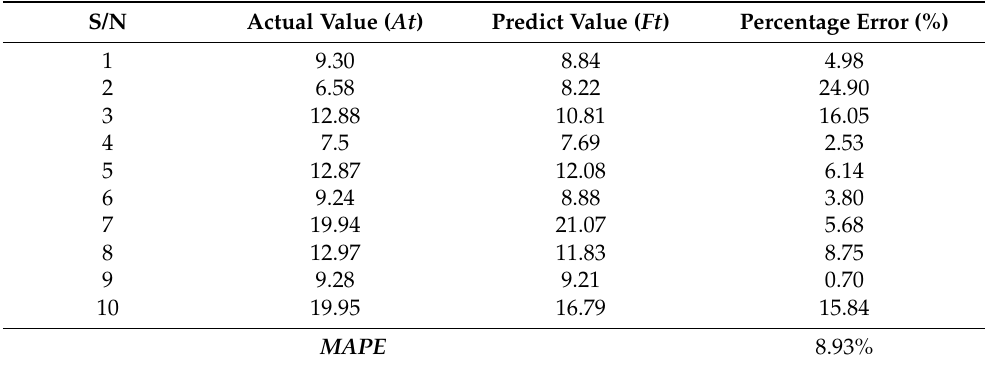
Table 8. Mean absolute percentage error (MAPE) of the regression model. S/N Actual Value ( At ) Predict Value ( Ft